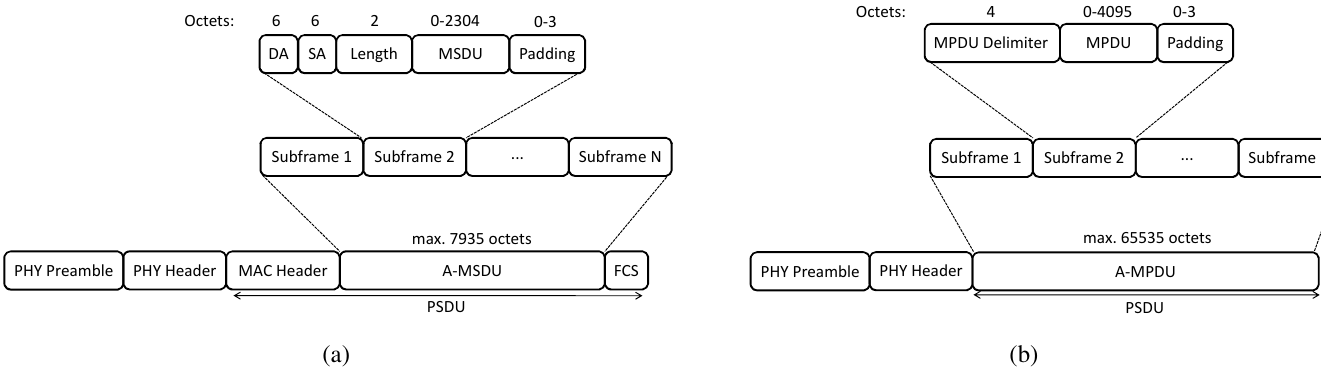
Figure 3. Frame aggregation schemes in next-generation WLAN: (a) A-MSDU, and (b)